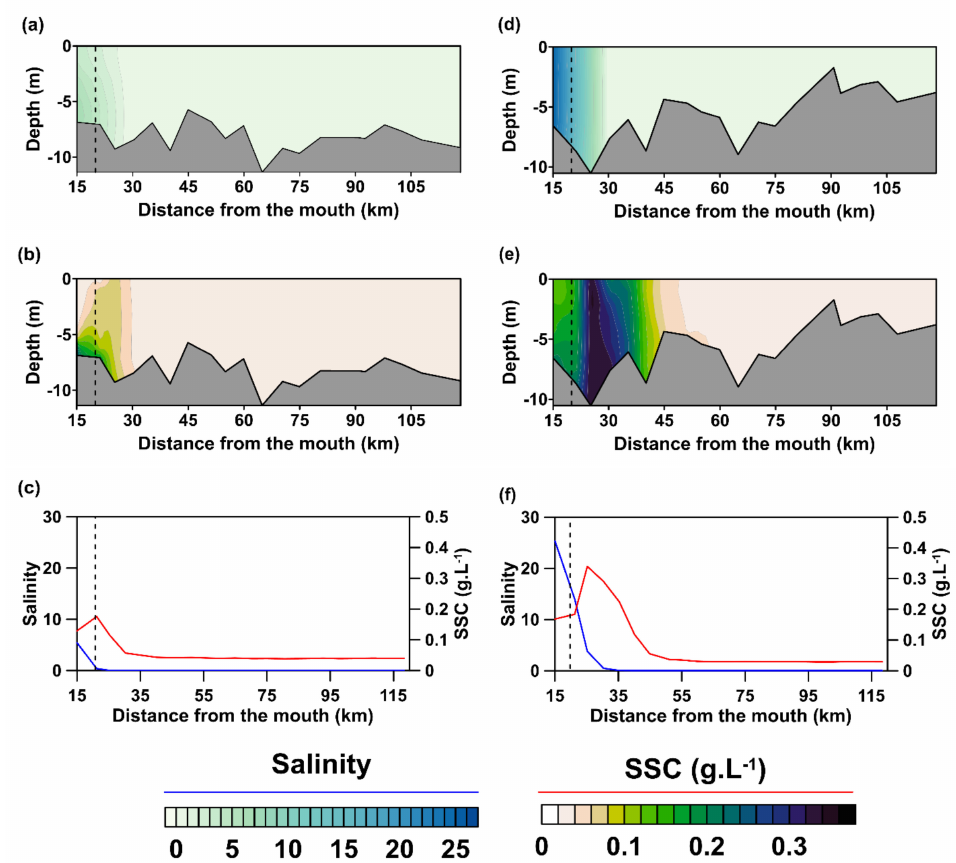
Figure 3. Longitudinal variation of salinity and SSC during the rainy ( a – c ) and dry ( d – f ) seasons (modified from [18]). The dashed line represents the location of the cross-sectional profile with ADCP. Notice that the location of the cross-section profile is the same for both